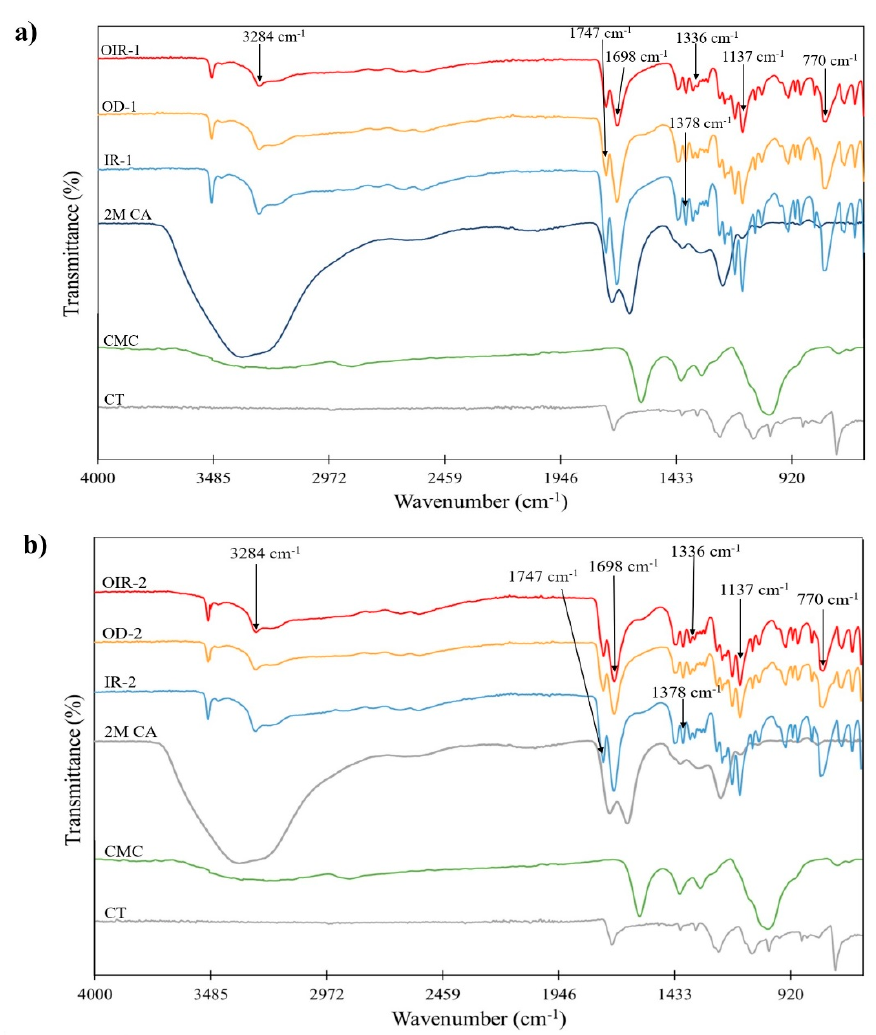
Figure 1. FTIR spectra of ( a ) single-coated and ( b ) double-coated CMC cross-linked with 2M CA in different drying regimes.